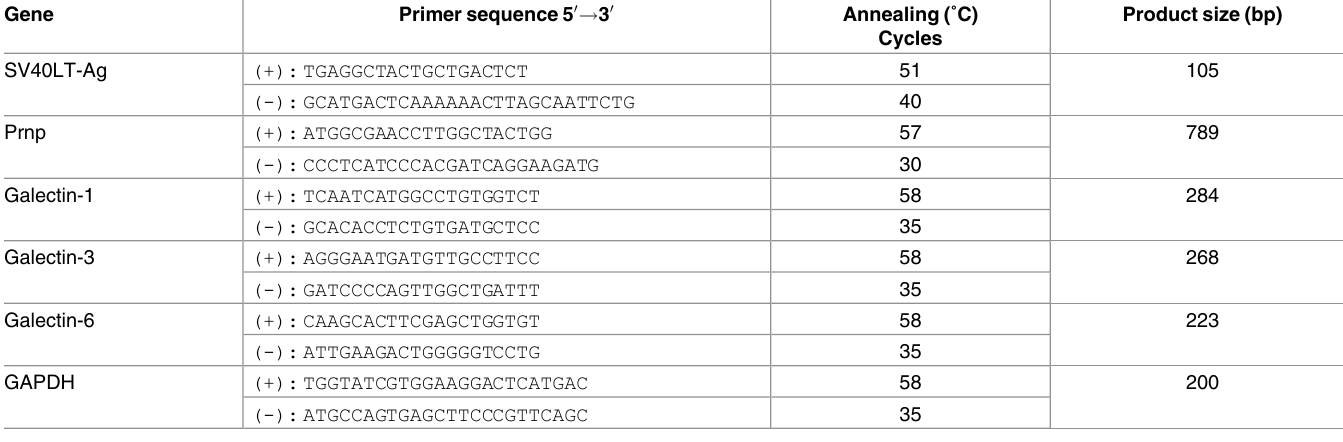
Table 2. Primer sequences and conditions for RT-PCR.